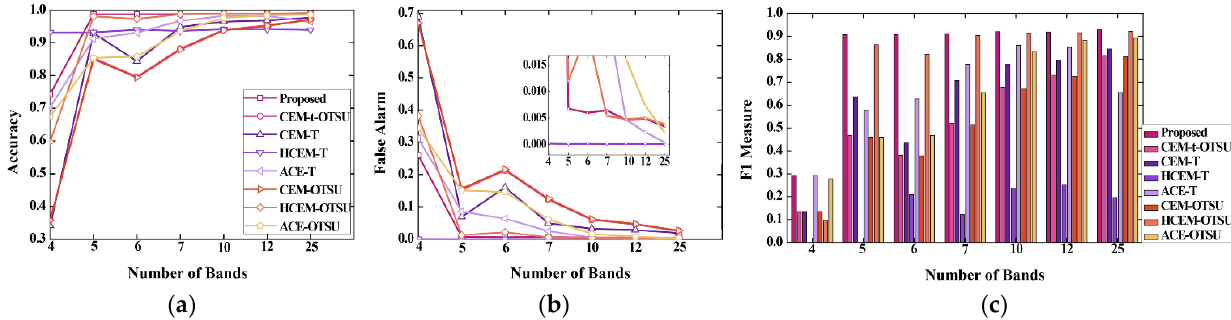
Figure 14. The quantitative comparison of AIRC-net detection results in the BT scene. ( a ) The curves of A C obtained using different methods; ( b ) The curves of F a obtained using different methods; ( c ) The histograms of F 1 obtained using different methods.